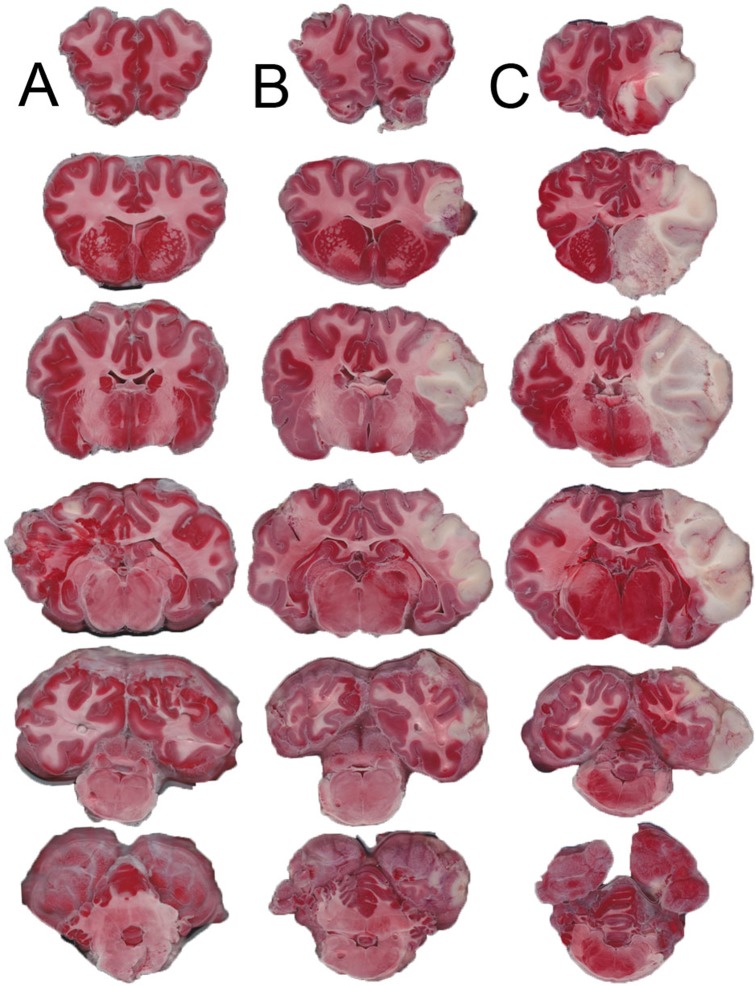
TTC at 24 hours, coronal stack.Unstained brain tissue represents cerebral ischemia. There is no evidence of ischemia in sham animals in the left column (A), small cortical ischemia in temporary MCAO animals in the center column (B), and large MCA territory ischemia in permanent MCAO animals in the right column (C). MCA, middle cerebral artery; MCAO, middle cerebral artery occlusion; TTC, 2,3,5-triphenyltetrazolium chloride, n = 5 shams, n = 11 transient MCAO, n = 8 permanent MCAO.